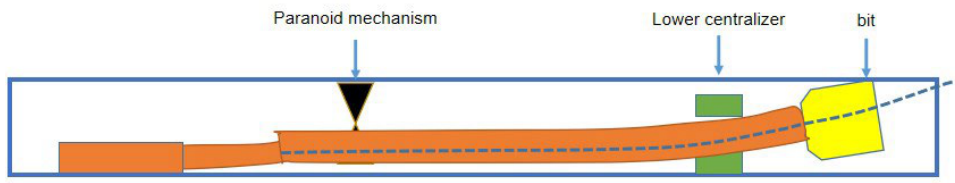
Figure 2. Schematic diagram of the steerable process of the new rotary steerable drilling system.